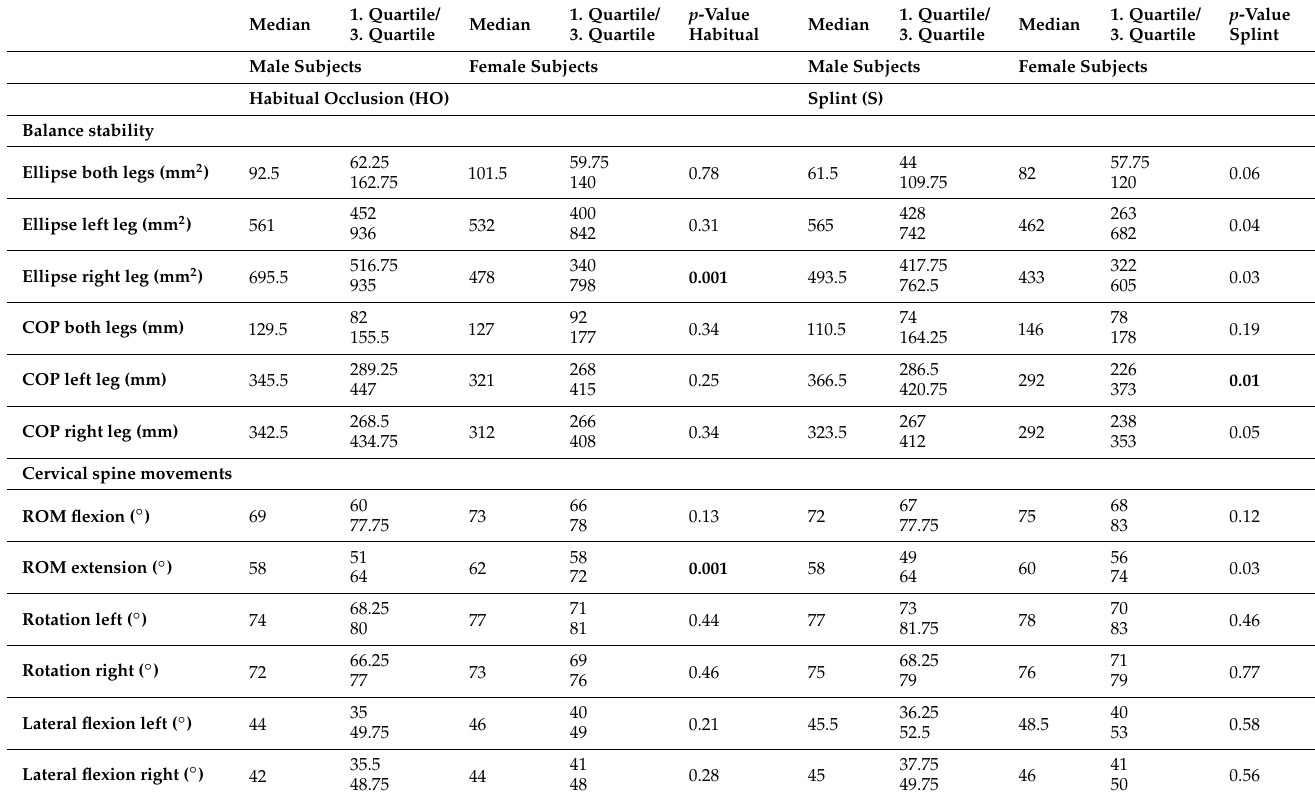
Table 1. Median, 1st and 3rd quartiles of all parameters for men and women. A comparison between men and women in the habitual occlusal position (HO) and the splint (S) condition. Significant p -values are marked in bold following Bonferroni-Holm